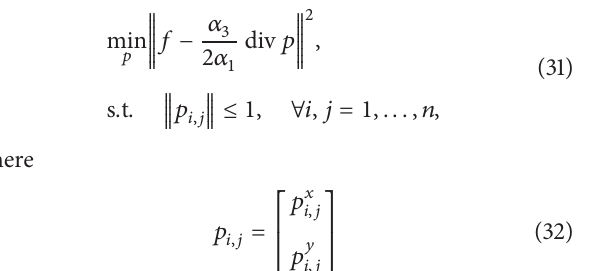
Algorithm 2: Alternating iteration scheme for solving